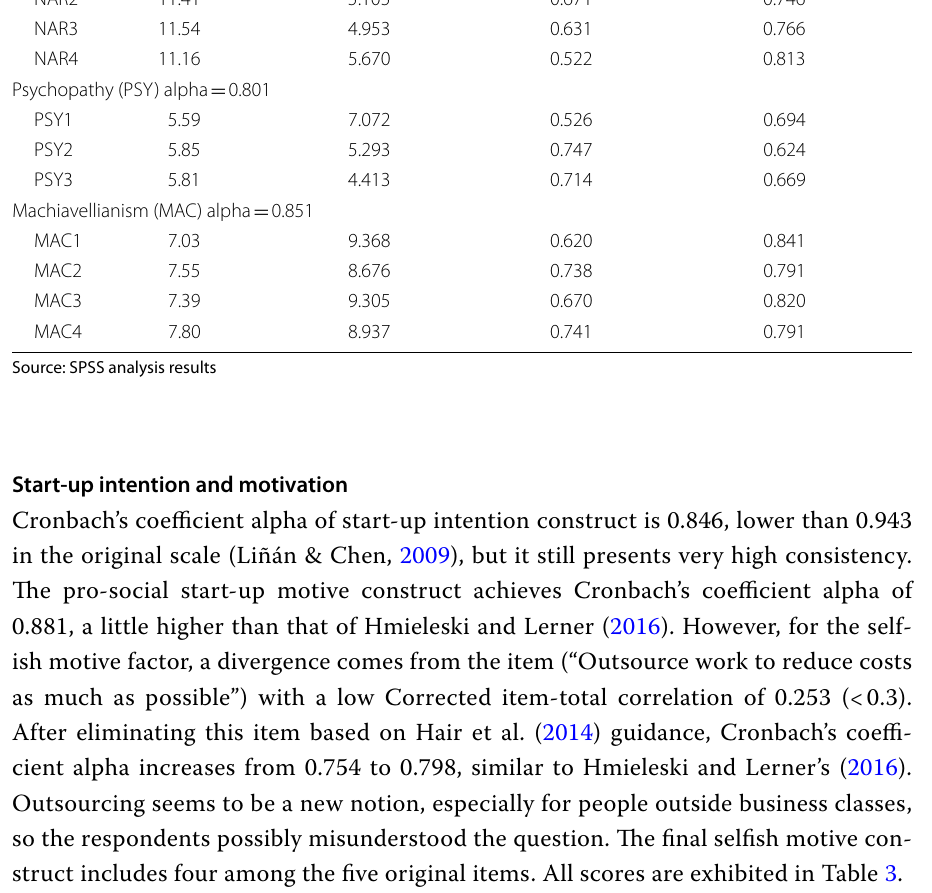
Table 2 Cronbach’s coefficient of the final three selfish personalities